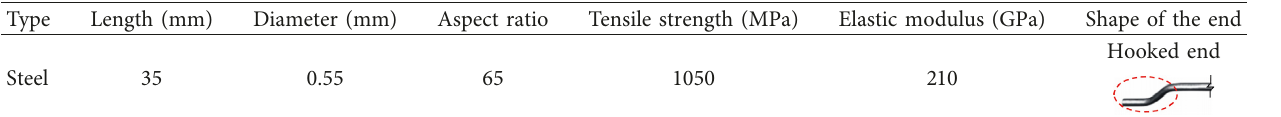
Table 3: Properties of steel fibers.